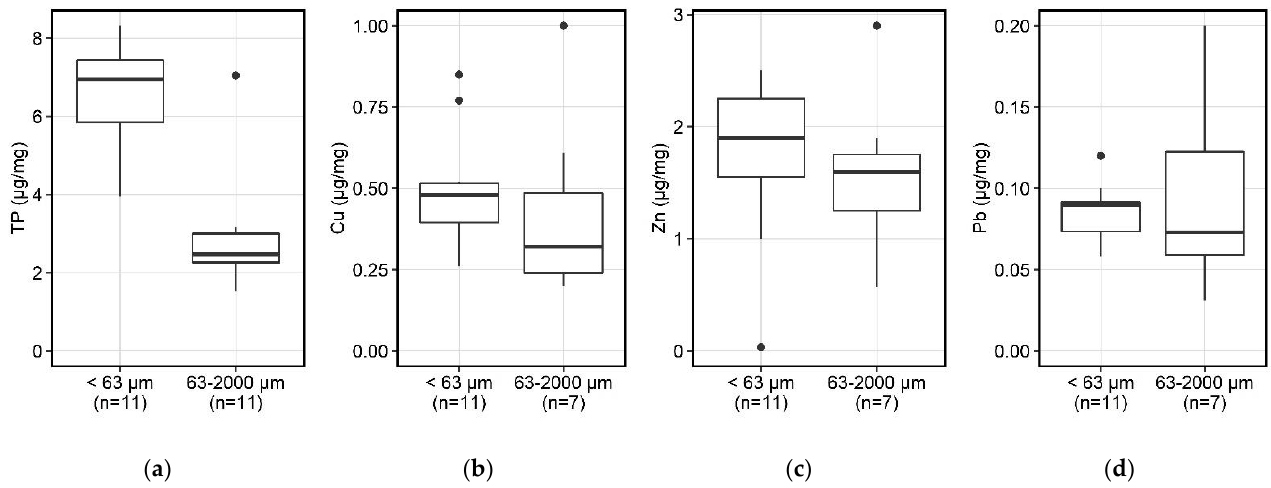
Figure 10. Pollutant loading of sedimented LVS samples collected from combined sewer overflows: ( a ) Total phosphorus (TP), ( b ) Copper (Cu), ( c ) Zinc (Zn), ( d ) Lead (Pb).